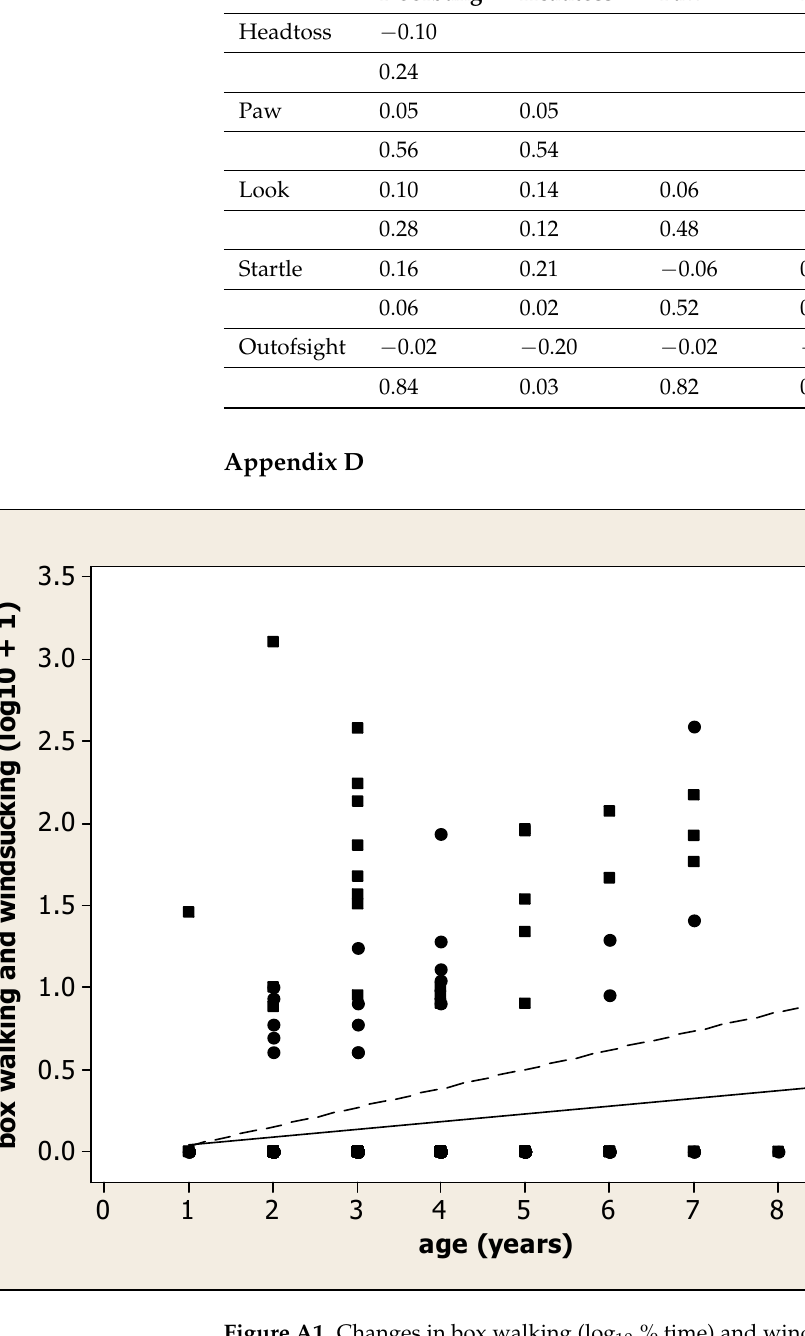
Figure A1. Changes in box walking (log 10 % time) and windsucking (log 10 % time) with age in years. Linear regression lines